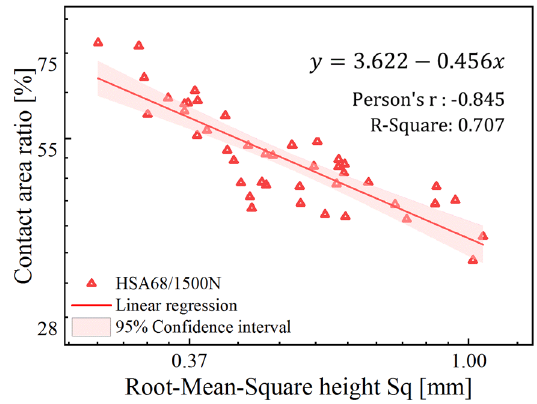
Figure 11. Log plot of the relationship between the contact area and the pavement texture under static condition of HSA68/1500 N.